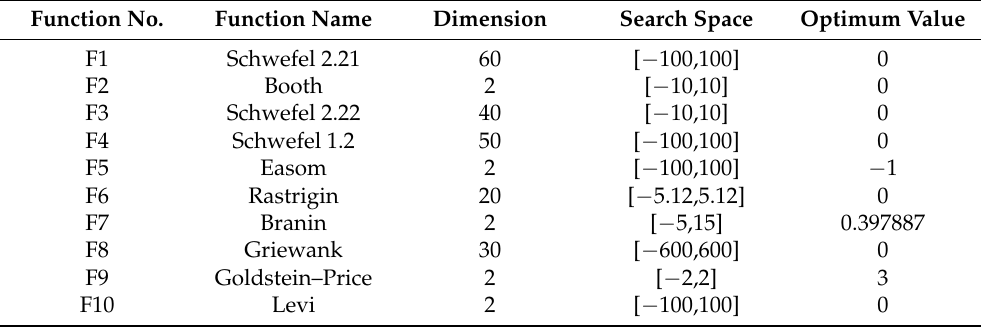
Table A1. Details on benchmark functions.